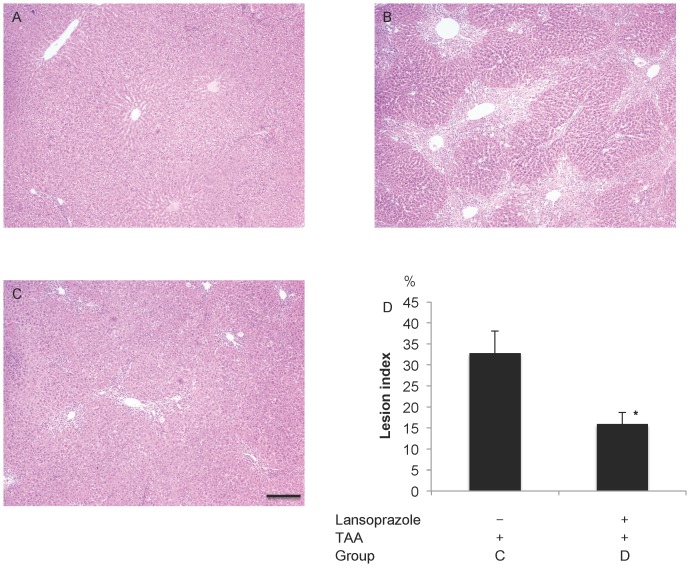
Histology of the liver stained with hematoxylin-eosin.A) Control (group A). B) TAA-treated liver (group C). C) TAA-treated liver pretreated by lansoprazole (group D), Bar = 250 µm. D) Lesion index (%). * P<0.05.